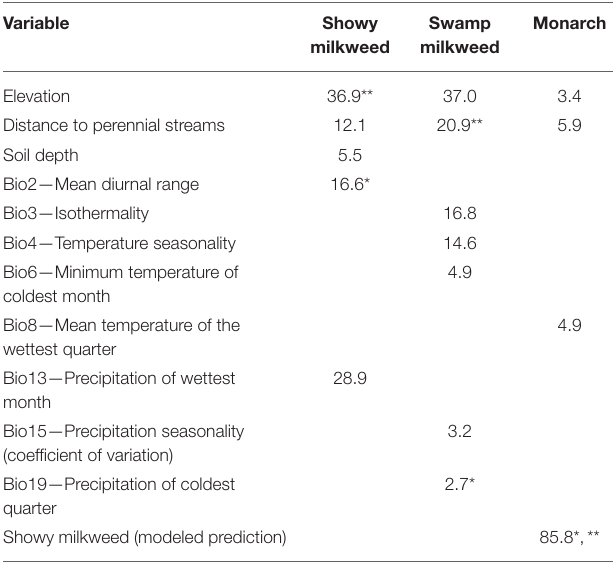
TABLE 2 | Most important variables based on percent permutation importance for the final monarch and milkweed models.